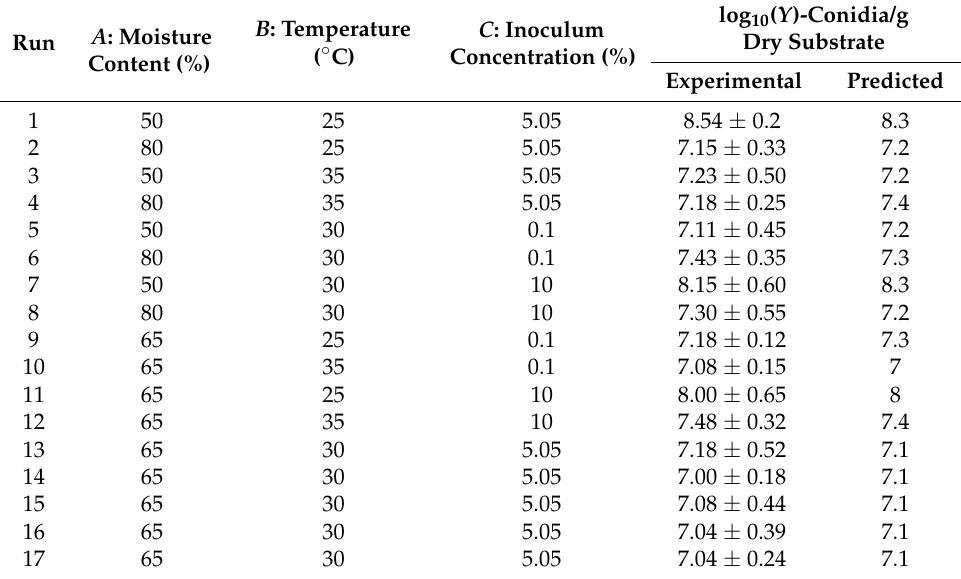
Each observed value is represented as mean ± standard deviation. Table 6. BBD matrix along with the experimental and predicted values for optimization of biomass production using T. longibrachiatum